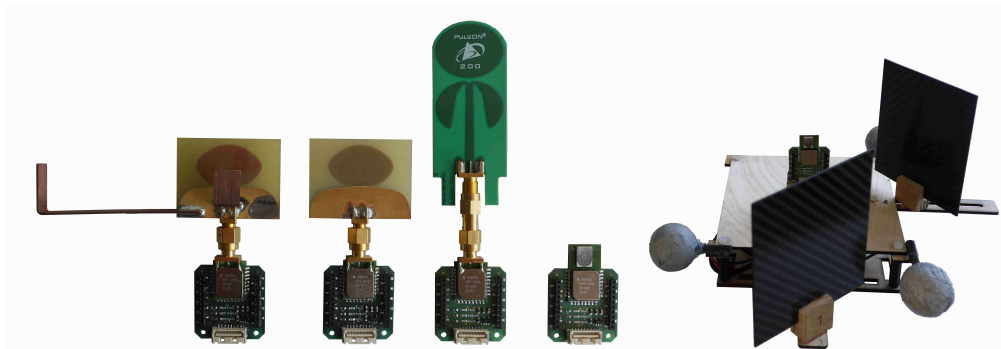
Figure 2. From left to right: A DWM1000 module equipped with a modified spline antenna, a spline antenna, a Broadspec Time Domain antenna, a Partron dielectric chip antenna. On the extreme right is a Partron dielectric chip antenna with carbon plates attached in its vicinity and the motion capture markers. This setup without the carbon plates is also used to collect measurements with the other